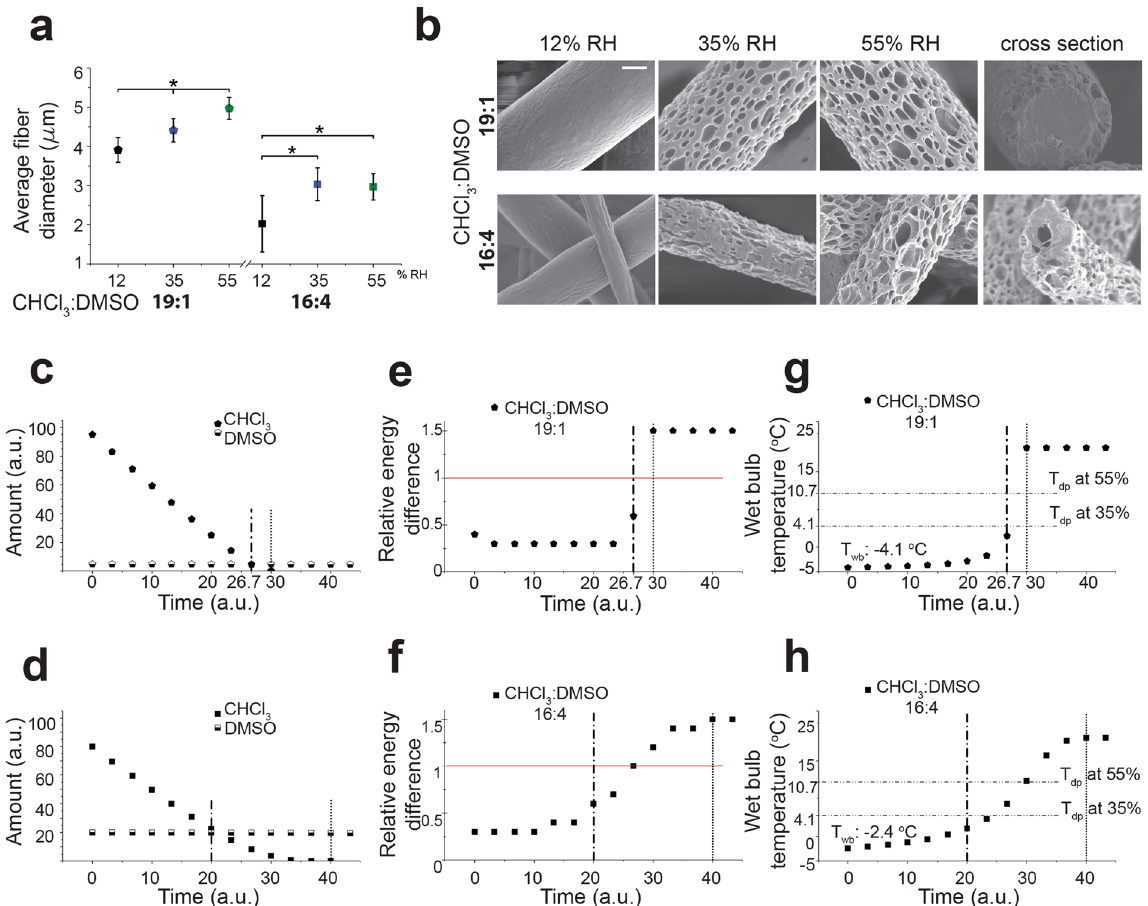
Figure 4. Resulting PCL fiber morphologies, simulated solvent evaporation and RED value changes during fiber formation for the solvent systems CHCl 3 :DMSO: ( a ) Average fiber diameter of electrospun fibers from CHCl 3 : DMSO with 19:1 and 16:4 ratios, Data represent means ± s.d. * P < 0.05; ANOVA One-way test, ( b ) SEM micrographs of electrospun fibers from CHCl 3 : DMSO solutions with 19:1 ratio (upper row) and 16:4 ratio (lower row) at 12, 35 and 55% RH, respectively (scale bar: 1 µ m), ( c , d ) simulated evaporation of CHCl 3 and DMSO from PCL solutions with 19:1 and 16:4 ratio, respectively (assuming the initial total amount of the solution is 100 parts and the solvent amount changes by evaporation during electrospinning), ( e , f ) simulated RED value change during solvent evaporation from CHCl 3 : DMSO solutions with 19:1 and 16:4 ratios, respectively, ( g , h ) wet bulb temperature change (°C) during solvent evaporation from CHCl 3 :DMSO solutions with 19:1 and 16:4 ratio, respectively, (dash-dot line) last time point of similar amounts of solvent (S) and non- solvent; (round dot line) time point S = 0; (red line) solubility limit for the polymer in the solvent